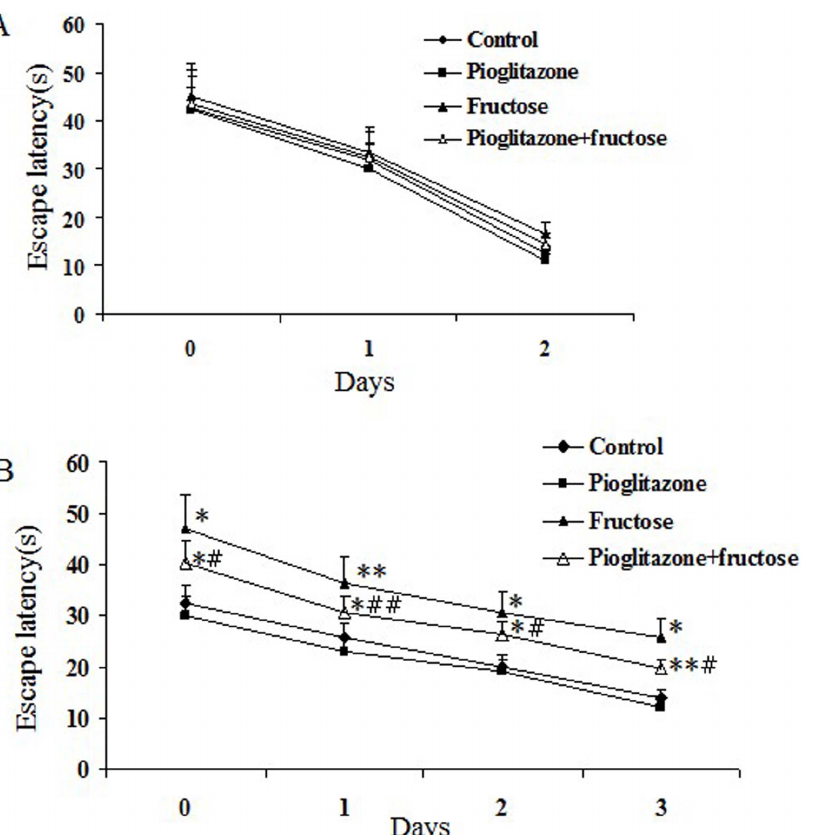
Figure 4. Effect of pioglitazone on memory impairment of fructose-drinking insulin resistance rats in MWM test. Day 0 represents performance on the first trial, and subsequent points indicate average of all daily trials. (A) No differences were found in the escape latency among four groups during the 2-day visible platform test. (B) Changes in escape latency to reach the hidden platform during the 3-day acquisition trials. Data are mean 6 SEM. The number of rats in groups control, pioglitazone, fructose and pioglitazone + fructose was 10, 9, 8, and 8, respectively. * P , 0.05, ** P , 0.01 versus control group; # P , 0.05, ## P , 0.01 versus untreated fructose-drinking group.